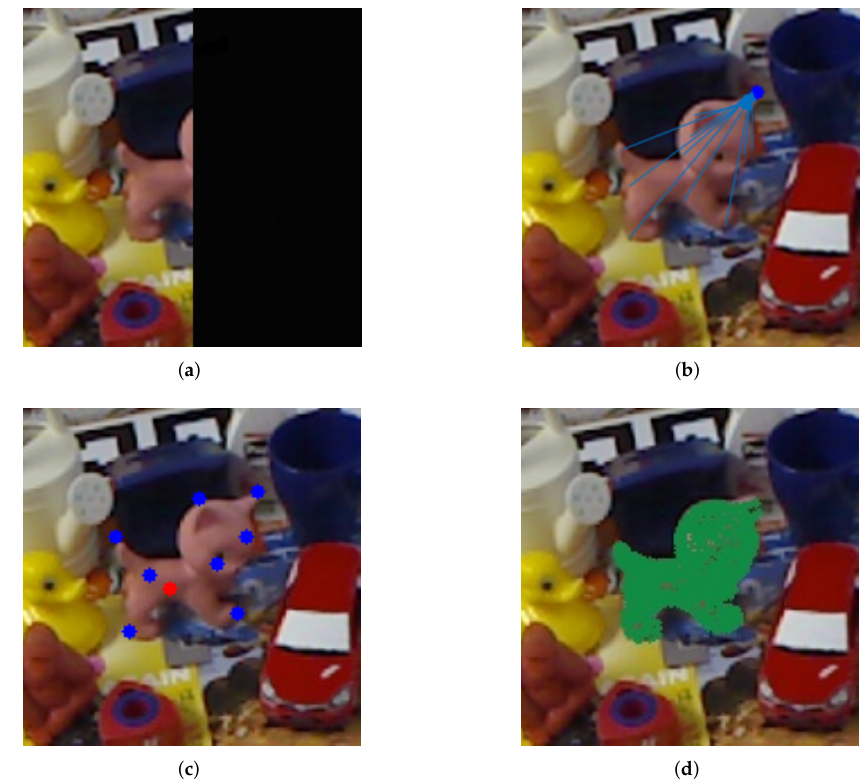
Figure 1. Pipeline of our proposed algorithm. ( a ) The RGB-D input data of our network; ( b ) The blue lines represent the direction vector to the keypoint; ( c ) The predicted 9 points, where 8 blue ORB-FPS keypoints and one red center point; ( d ) The 6DoF pose estimated by our